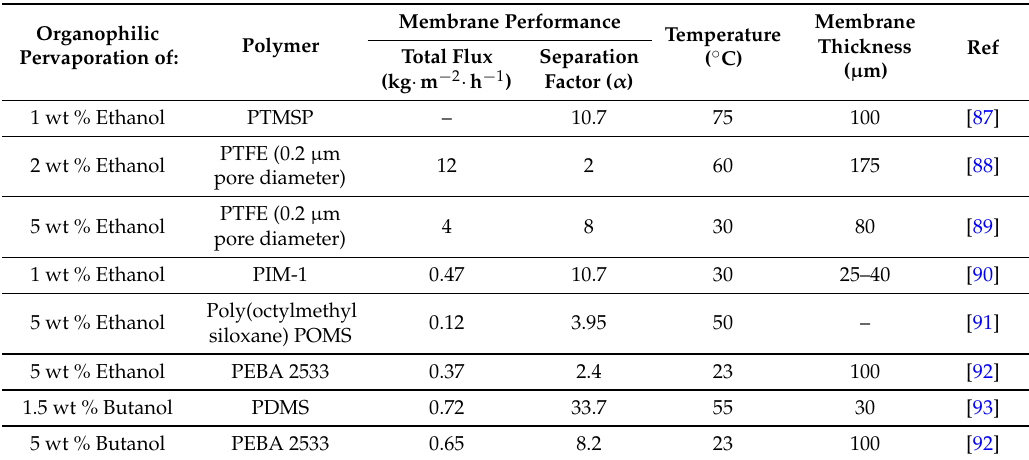
Table 3. Organophilic pervaporation by various polymer